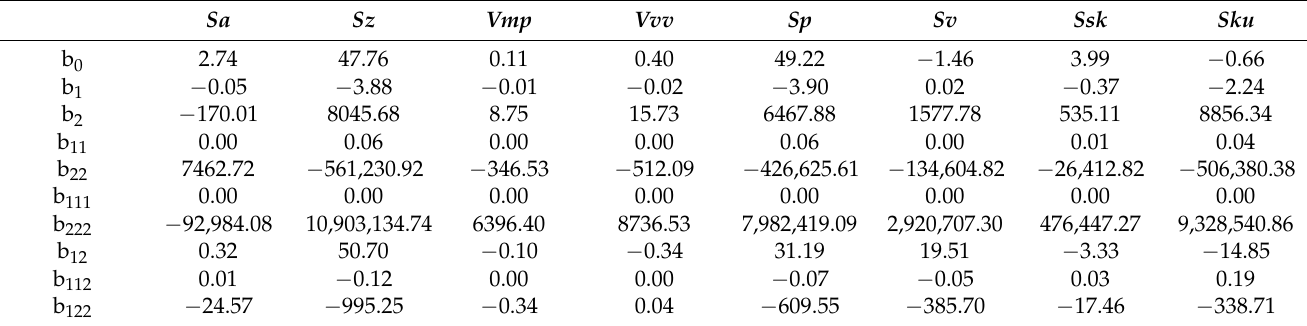
Table A7. Coefficients of the response functions for